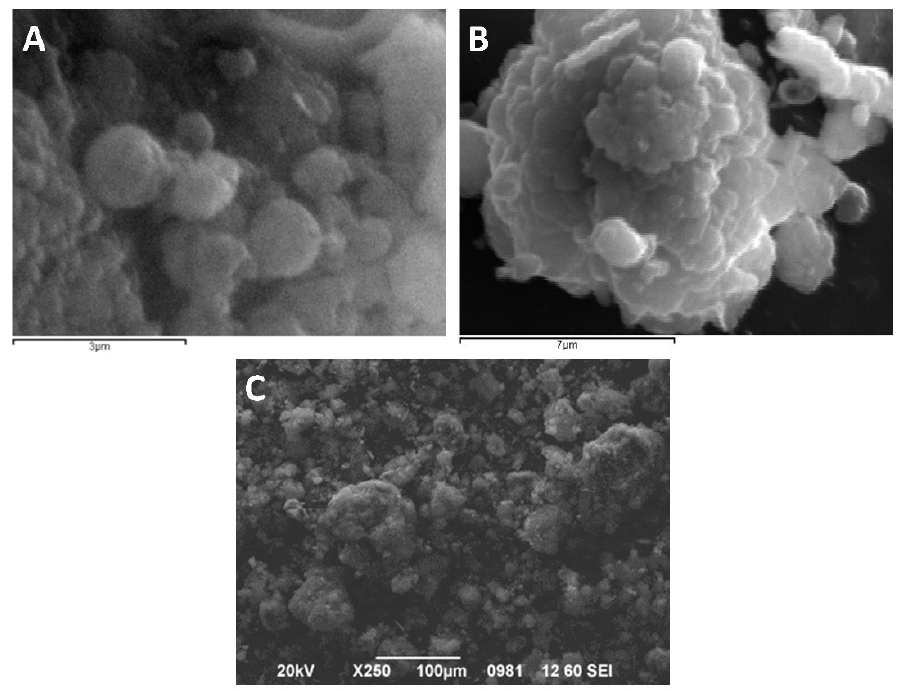
Figure 8. SEM micrographs of the dry particles, taken for different angles and magnification. ( A ) Representative spherical nanoparticles and small particle clusters, ( B ) Large-sized spherical particles cluster, and ( C ) particle cluster of different sizes.